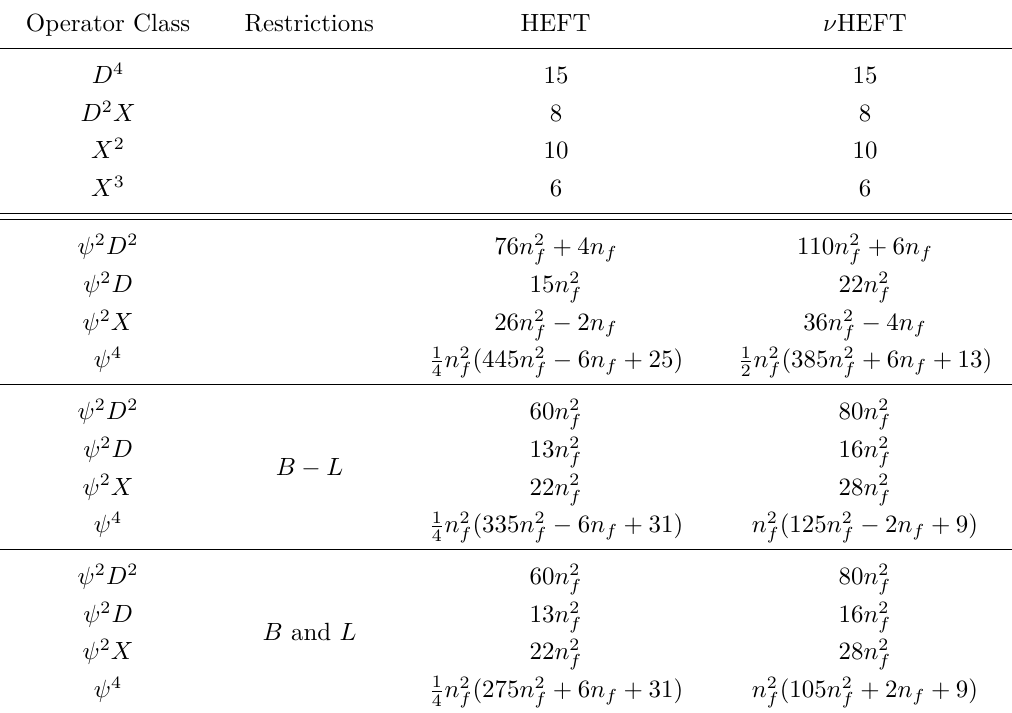
Table 3 . Eight classes of operators that are relevant for “NLO” ( ν )HEFT. For the fermionic classes, we are presenting three different scenarios — (1) no additional Baryon number B or Lepton number L restrictions, (2) requiring B − L conservation, and (3) requiring both B and L